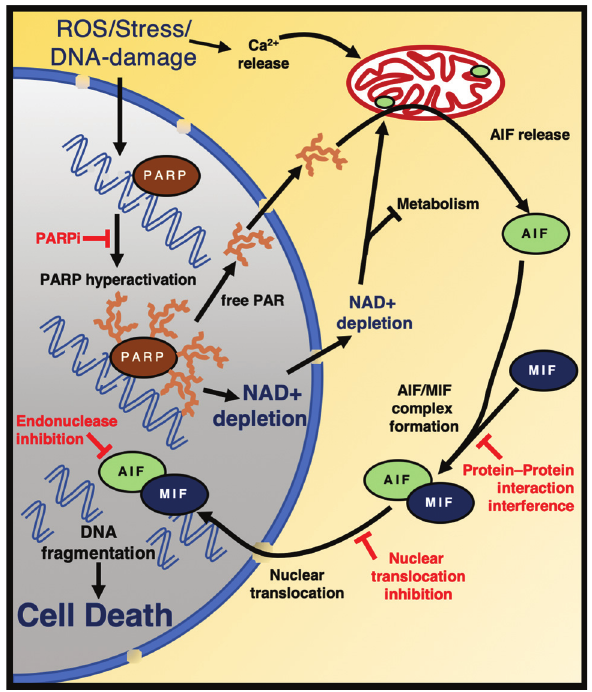
Figure 3 - PARP1 mediates cell death by Parthanatos. Oxidative damage triggers PARP-hyperactivation, resulting in AIF release from the mito- chondria and nuclear translocation of the AIF/MIF complex. Endonu- clease activation causes cell death. Some of the potential therapeutic tar- gets are depicted in red. The nucleus is coloured in grey and cytoplasm in orange. AIF: Apoptosis Inducing Factor. MIF: macrophage migration in- hibitory